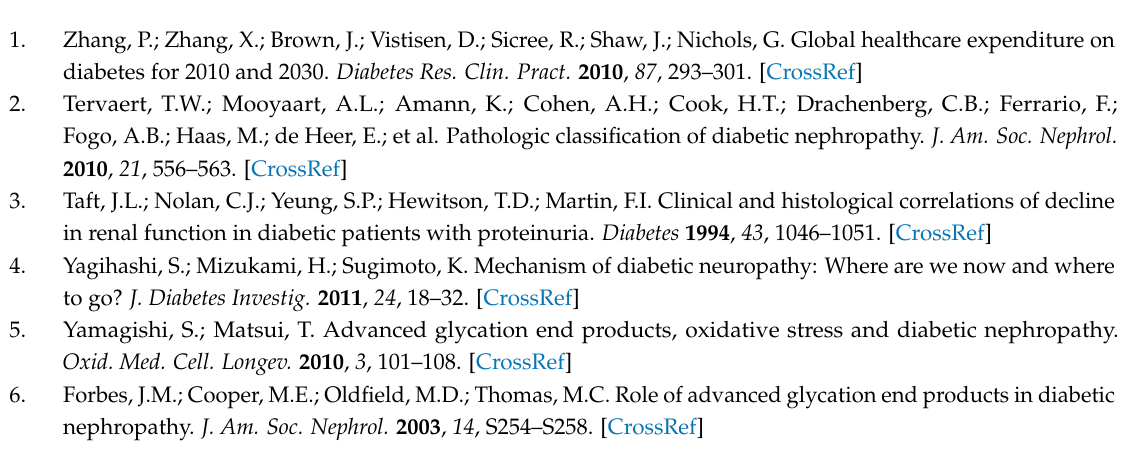
Figure S1: Impact of NGR1 on diabetes-induced apoptosis in kidney tissue stained by TUNEL. Author Contributions: B.Z., G.S., and X.S. designed the research; B.Z., X.Z., C.Z., and Q.S. performed the the final